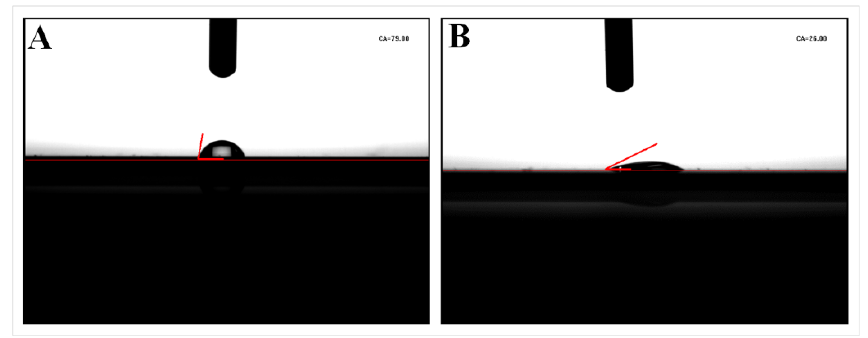
Figure 5. Contact angle of delay line before ( A ) and after immobilization of Ab 1 ( B